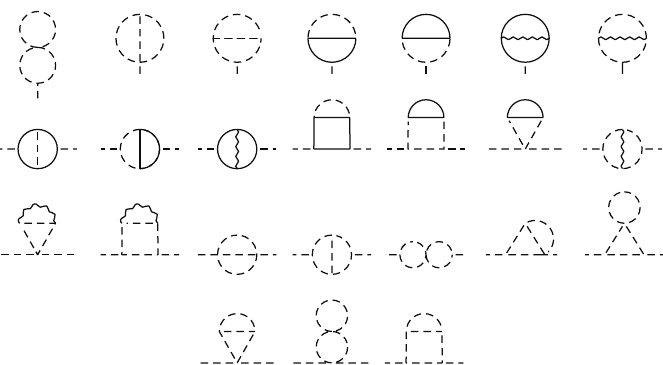
Figure 3: Generic diagrams included to calculate the two two-loop corrections to tadpoles and scalars. These are the diagrams which do not vanish in the